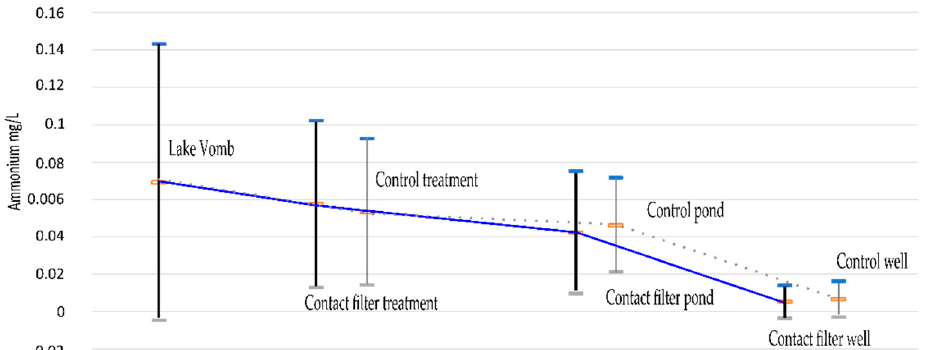
Figure 6. Nitrate content at different stages along the two treatment processes (mg/L). The middle bar is the mean value and the top and lower bars show the standard deviation. The dotted line is the contact filter treatment process and the solid line is the control treatment process.